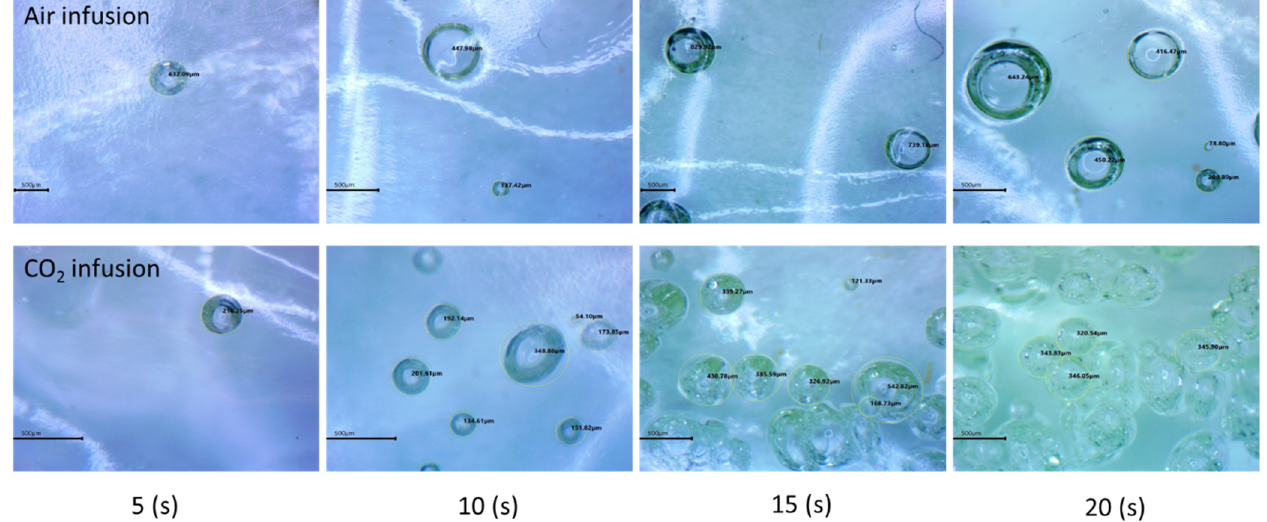
Figure 3. Optical microscopy of oxygenated and carbonated polymer samples at increasing mixing durations.